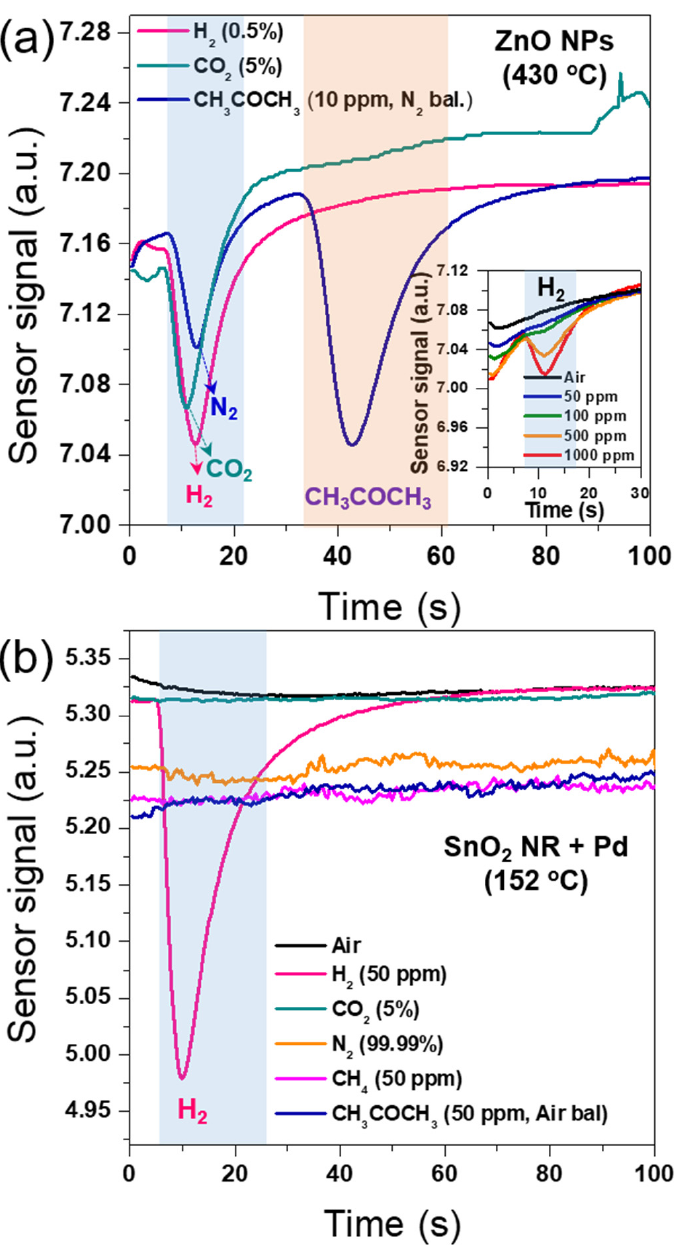
Figure 5. ( a ) Sensor signals for H 2 , CO 2 , and CH 3 COCO 3 in the mini-GC integrated with ZnO nanoparticles (Inset: the cases of low H 2 concentration (50–1000 ppm); ( b ) sensor signals for air, H 2 , N 2 , CO 2 , CH 4 , and CH 3 COCH 3 in the mini-GC integrated with Pd-coated SnO 2 NR arrays.